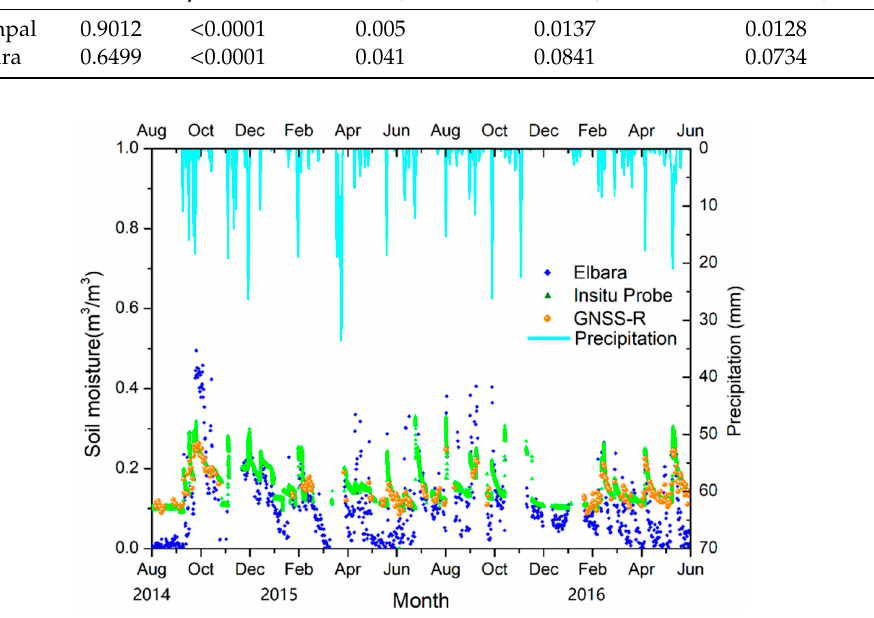
Figure 10. GNSS-R soil moisture as compared to ELBARA-II and ThetaProbe soil moisture as reference.